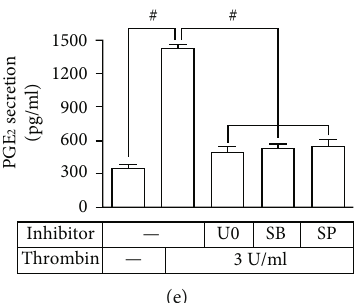
Figure 4: Thrombin induces COX-2 expression via MAPKs. (a) Cells were pretreated with SB202190, U0126, or SP600125 for 1 h and then incubated with thrombin for 6 h. The levels of COX-2 protein were determined by Western blot. (b) Cells were pretreated with U0126 (10 μ M), SB202190 (10 μ M), or SP600125 (10 μ M) for 1h and then incubated with thrombin for 4h. The mRNA levels and promoter activity of COX-2 were determined. (c) Cells were transfected with scrambled, p38, p42, or JNK2 siRNA and then incubated with thrombin for 6h. The levels of p38, p42, JNK2, and COX-2 protein were determined. (d) Cells were pretreated without or with SB202190 (10 μ M), SP600125 (10 μ M), U0126 (10 μ M), or Gö6976 (3 μ M) for 1h and then incubated with thrombin for the indicated time intervals. The levels of phospho-p38 MAPK, phospho-p42/p44 MAPK, and phospho-JNK1/2 were determined by Western blot. (e) The media saved from (a) were used to determine the levels of PGE2 generation. Data are expressed as mean ± S : E : M : of three independent experiments. # P < 0 : 05 , as compared with the control or pretreatment with inhibitor indicated in the fi